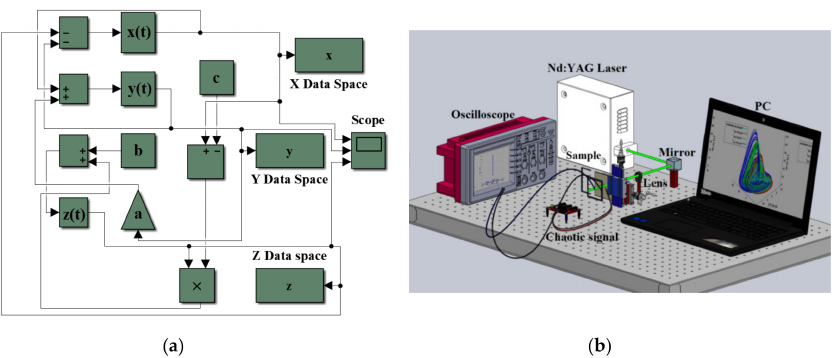
Figure 1. ( a ) Experimental procedure block diagram for implementing a Rössler attractor system. ( b ) Schematic illustration of the laser ablation experiment controlled by a T-type flip-flop with a steady-state Rössler attractor as an input